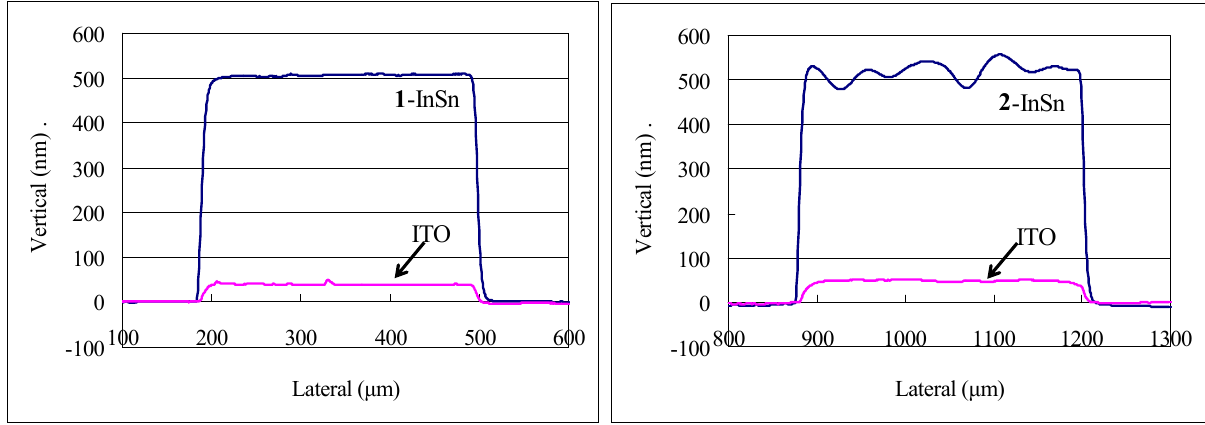
Figure 10. Surface profiles of patterned 1 -InSn and 2 -InSn films on each side of a quartz substrate deposited by two-tone patterning Method A and the resulting indium tin oxide (ITO) films formed by pyrolysis at 500 °C.